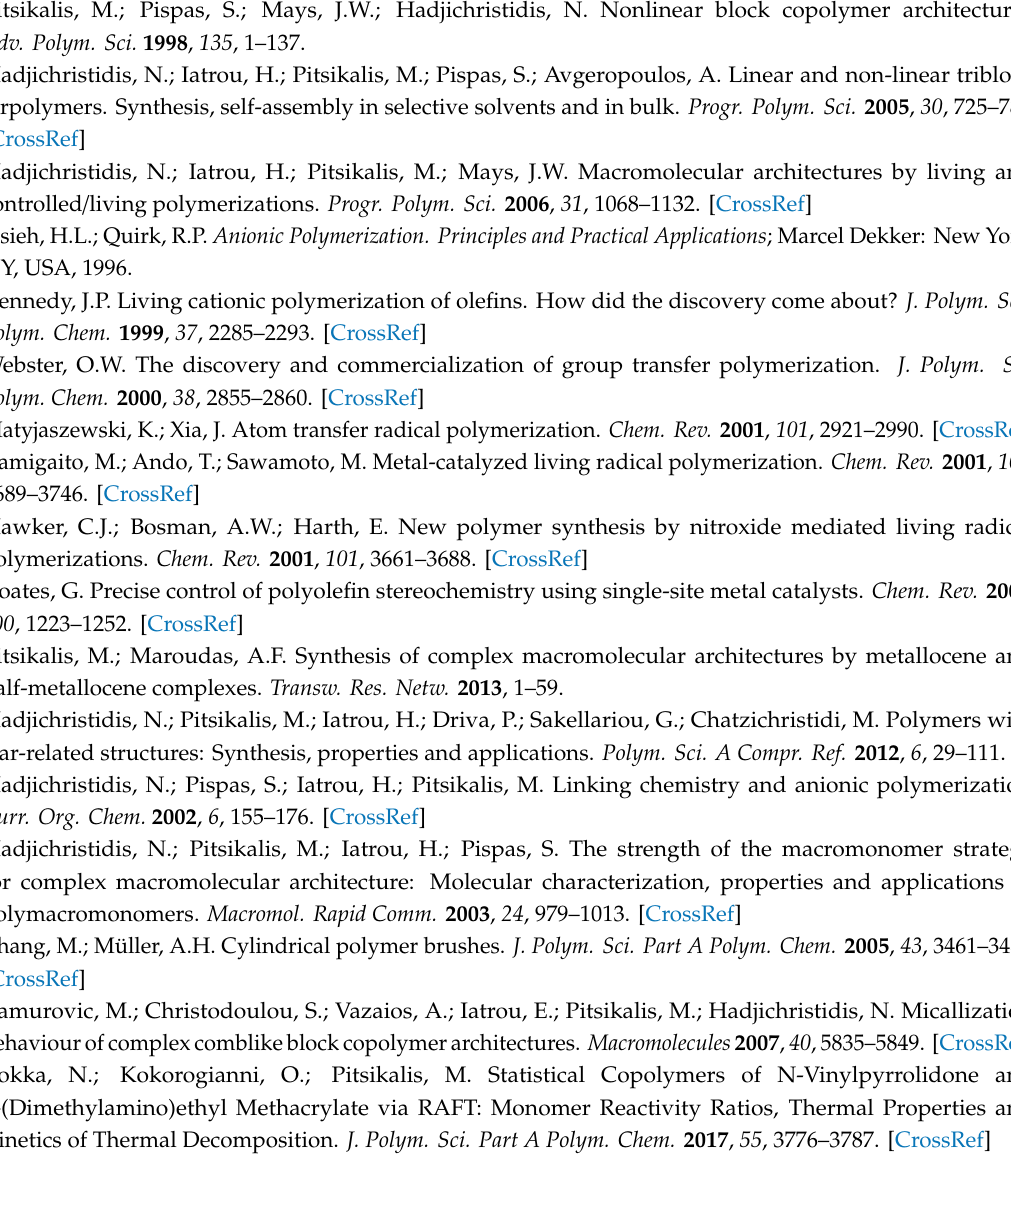
Figure S1: 1 H-NMR spectrum of sample PS- b -PI-OH. Figure S2: 1 H-NMR spectrum of sample PS- b -PI-Acrylated. Figure S3: Monitoring the synthesis of PS-Ham by SEC chromatography, in CHCl 3 at 25 ◦ C. Figure S4: PS-Isophthalamide before and after fractionation, by SEC chromatography, in CHCl 3 at 25 ◦ C. Figure S5: Huggins plots for samples Blend #0, Blend #1, and Blend #2. Figure S6: DTG plots of the samples PS-Dap, PS- b -PI-Thy, and Blend #1. Figure S7: DTG plots of the samples PS-Ham, PS- b -PI-Thy, and Blend